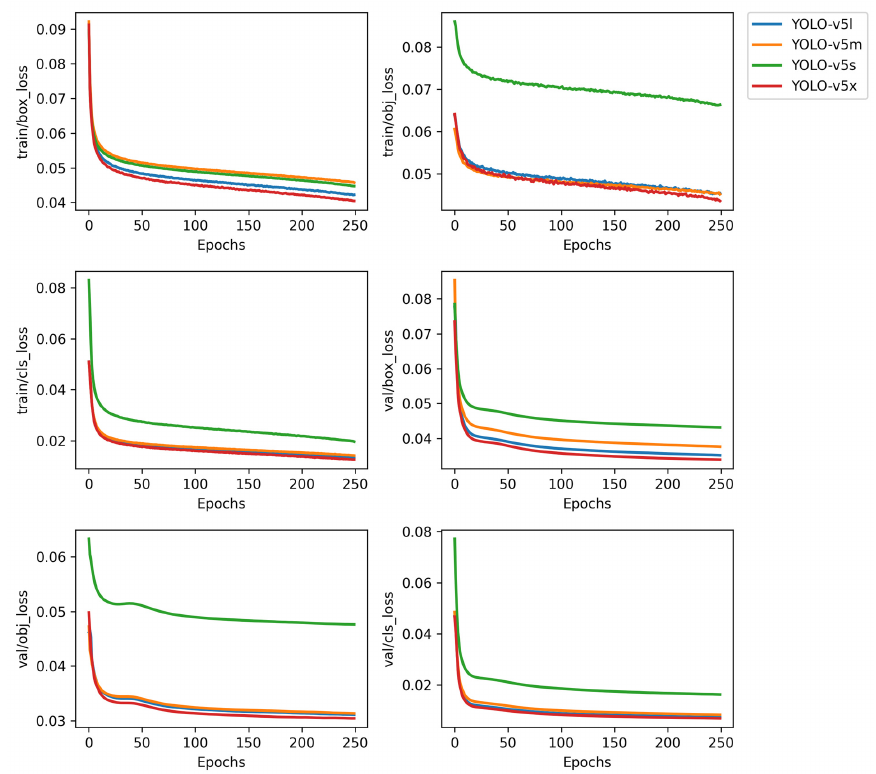
Figure 9. Training parameter optimization results of the proposed VPP framework based on various deep learning YOLO structures (i.e., YOLOv5s, YOLOv5m, or YOLOv5l) in terms of train/valid detected box, object, and cls loss functions.